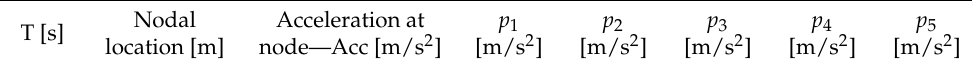
Table 1. Tabular setup of the variables for training of the machine learning algorithm.